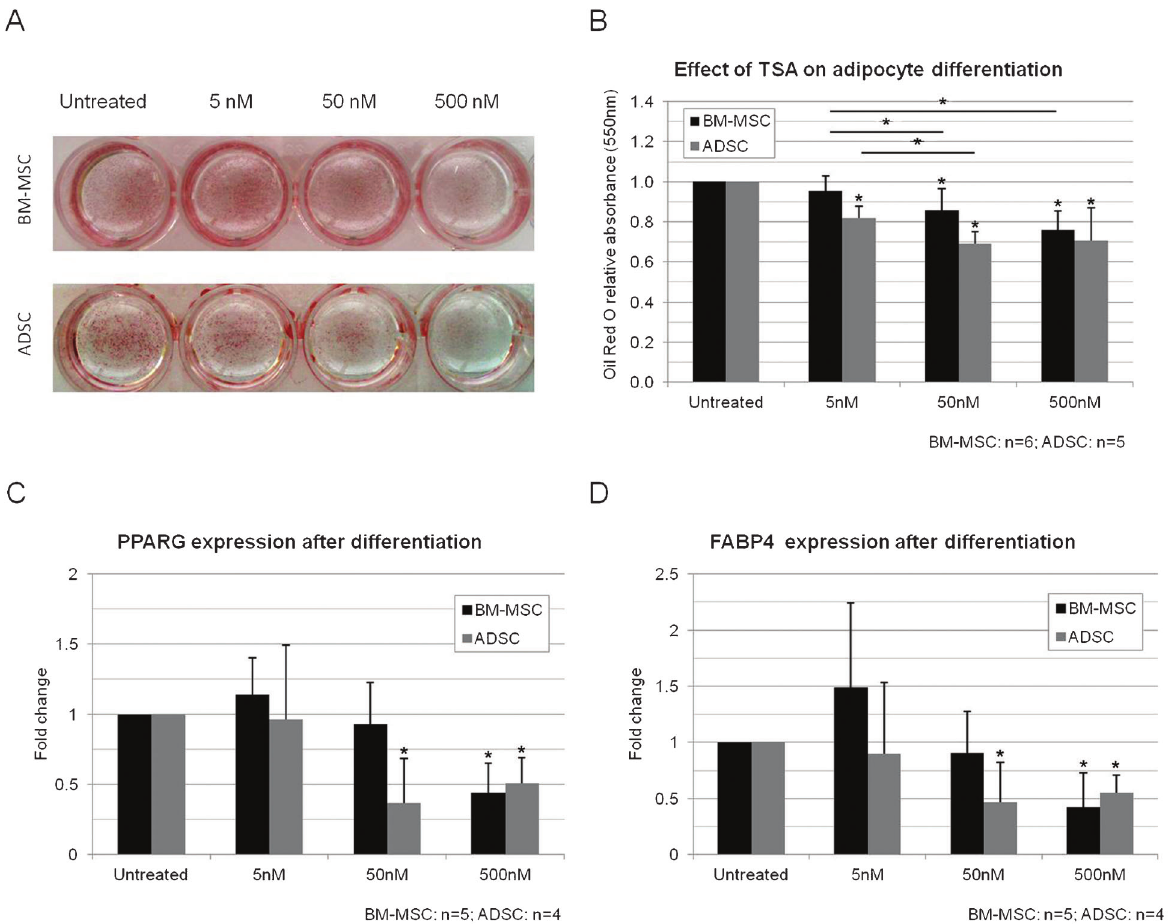
Figure 4. Effect of treatment with TSA (5, 50 and 500 nM) on differentiation of MSCs. A , Effect of TSA on the adipogenic differentiation of BM-MSCs and ADSCs observed in cell cultures after staining with Oil Red O. B , Relative quantification of adipocyte differentiation. C , PPARG and D , FABP4expressioninthecultures after14daysofadipocytedifferentiation.TSA=trichostatinA;MSCs =mesenchymal stem cells; BM-MSCs = bone marrow MSCs; ADSC = adipose tissue stem cells. Data are reported as means ± SD. Asterisks just above SD bars indicate statistically significant differences with respect to untreated cultures of BM-MSCs or ADSCs. *P , 0.05 (Student t